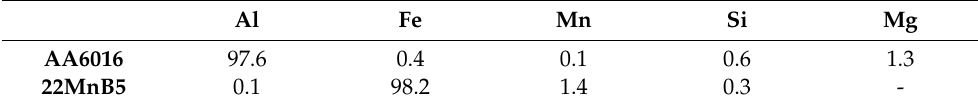
Table 1. Chemical composition (in wt.%) of flyer (AA6016) and target material (22MnB5) according to EDX